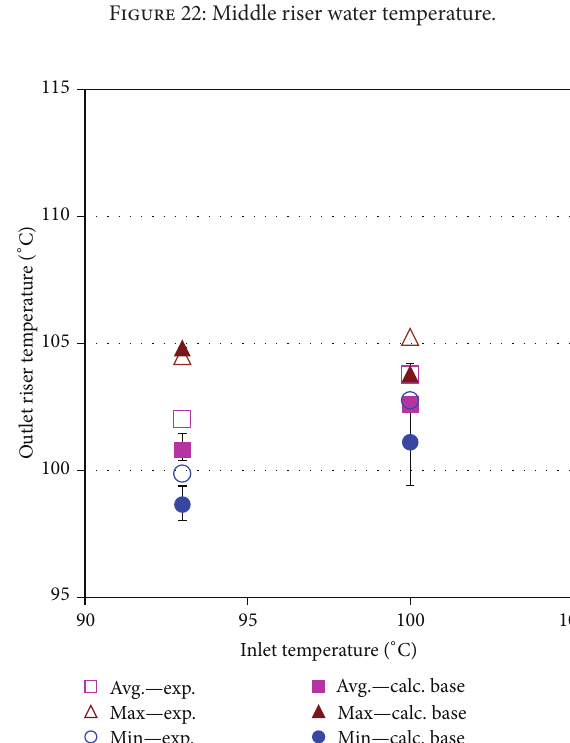
Figure 20: Inlet pressure.